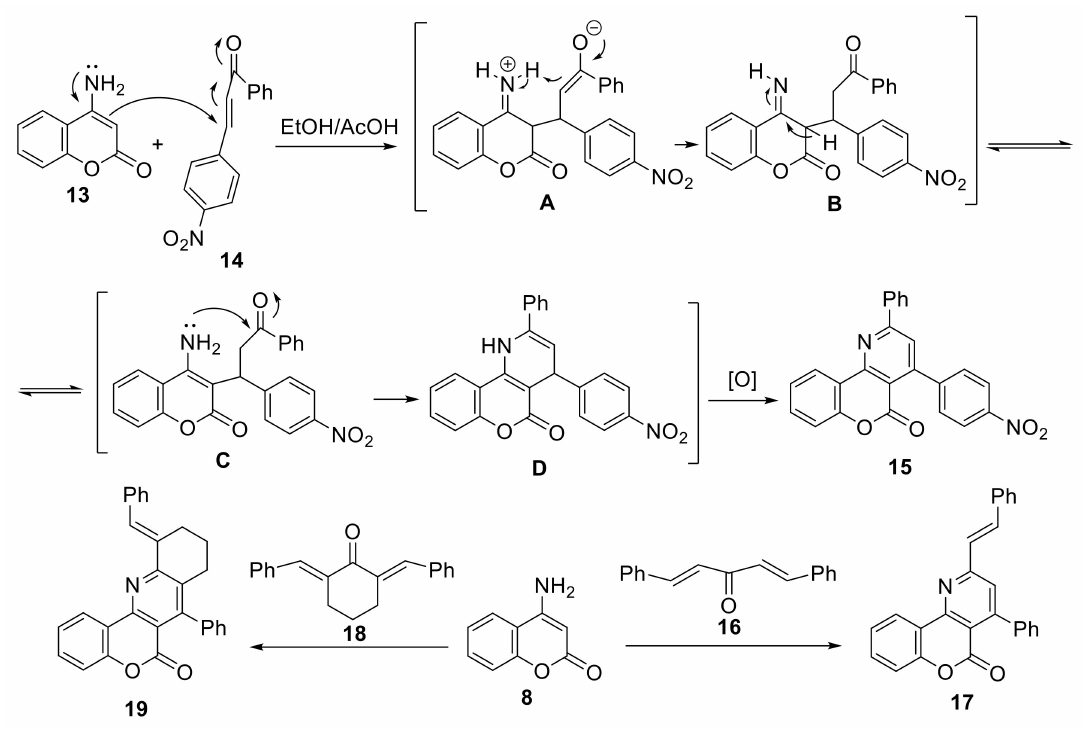
Scheme 3. Reactions of 4-aminocoumarin ( 13 ) with the α , β -unsaturated ketones 14 , 16 , 18 for the synthesis of pyridocoumarins 15 , 17 , 19